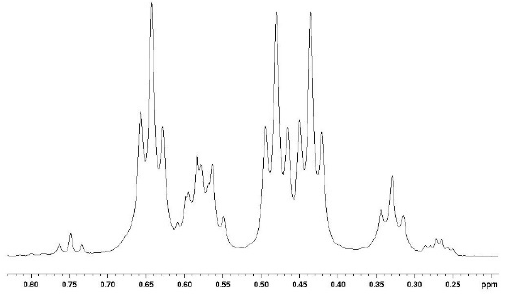
Figure 5. High field part of the 1 H NMR spectrum of the mixture of tri-adducts showing similar intensities for three CH 3 -18 in the major isomer.